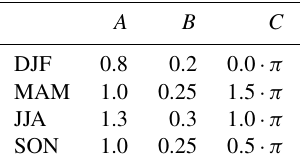
Table 1. Scaling constants and phase shift for each